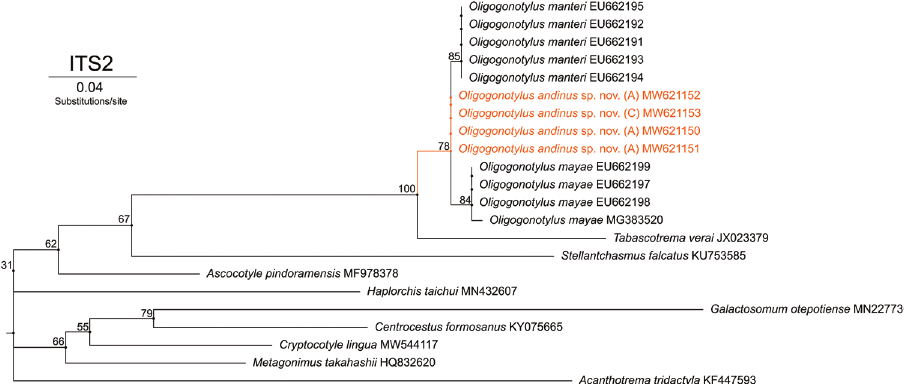
Figure 5. Phylogenetic relationships of ITS2 sequences of Oligogonotylus andinus sp. nov., Oligogonotylus manteri , and Oligogonotylus mayae . Phylogenetic tree reconstructed using the maximum-likelihood method based on the symmetrical model with gamma distribution (SYM+G). Numbers on the branches correspond to the ultrafast bootstrap approximation support values. Each terminal is identified by the alphanumeric accession number of GenBank. Terminals in orange correspond to the sequences obtained in this report. Diagram made with IQ-TREE 2.1.3.